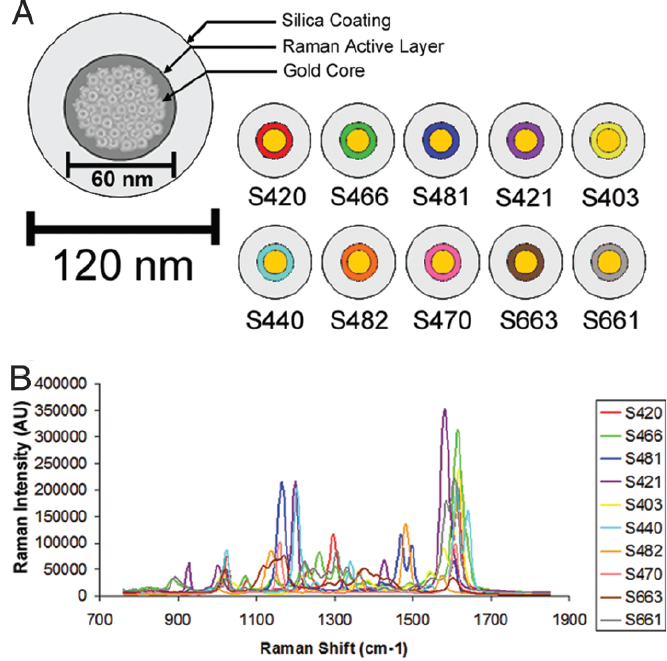
Figure 5. Schematic representation of a SERS Raman nanoparticle and graph depicting unique Raman spectra associated with each of the 10 SERS nanoparticles used for in vivo multiplexed imaging. (A) Schematic of a SERS Raman nanoparticle consisting of a 60-nm gold core with a unique Raman active layer adsorbed onto the gold surface and coated with glass totaling 120 nm in diameter. The trade name of each SERS nanoparticle is depicted to the right, where a color has been assigned to the Raman active layer of each SERS nanoparticle. (B) Graph depicting Raman spectra of all 10 SERS nanoparticles; each spectrum has been assigned a color corresponding to its unique Raman active layer as shown in (A). © The National Academy of